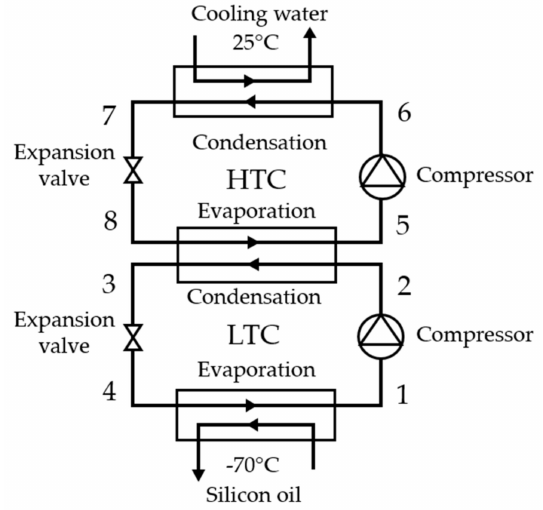
Figure 1. Scheme of the two-stages refrigeration cycle considered for the calculation of the power consumption attributed to the refrigeration system. The numbers refer to the thermodynamics states of the refrigerant